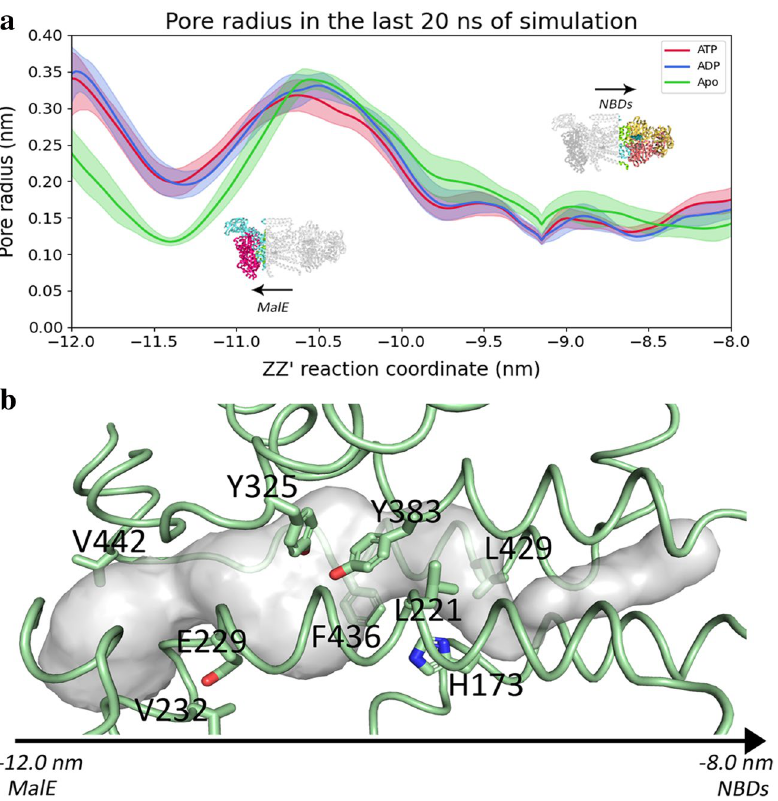
Figure 4. Pore radius across the channel. ( a ) Pore radius across the channel in the last 20 ns of simulation. The ATP state is represented in red, while the ADP one in blue. The observed values are the average for each state and the error bars represent the 95% confidence interval obtained by bootstrapping. Larger values of the zz’ reaction coordinate indicate a path towards the intracellular medium, while lower values indicate the direction towards MalE and the periplasmic medium. ( b ) Pore representation with relevant residues. The pore surface was generated using HOLE 65 . The residues are displayed in sticks, the pore volume as surface and the protein backbone as ribbon. The bottom of the pore heads towards the periplasmic